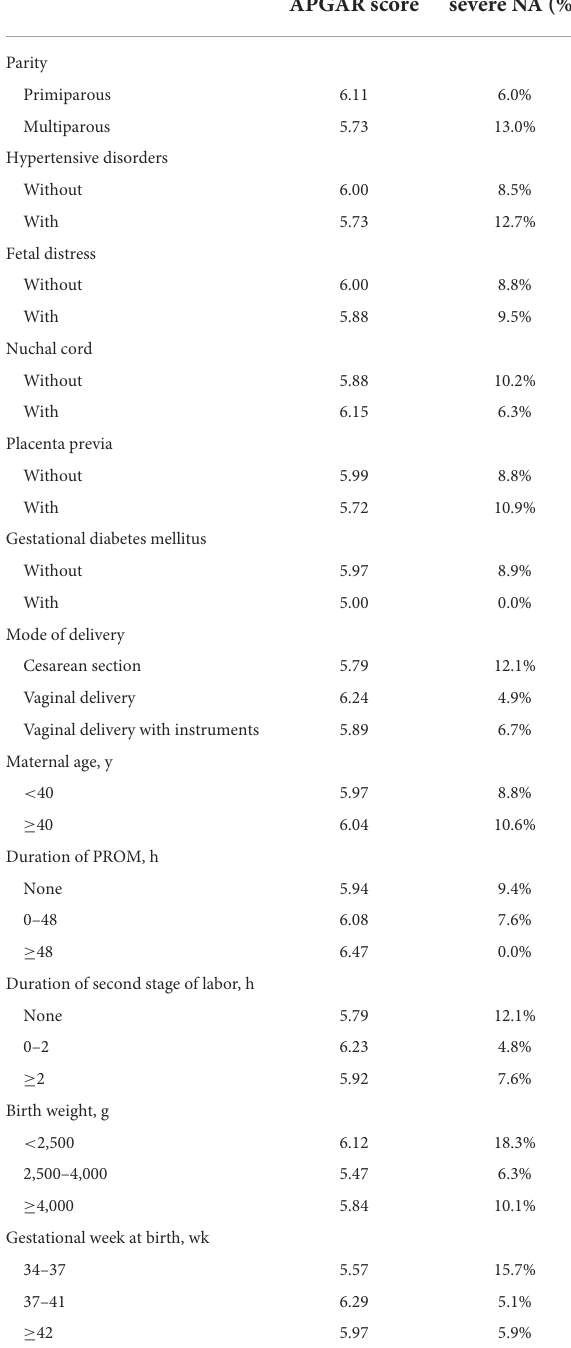
TABLE 7 Influence of the variables in the APGAR